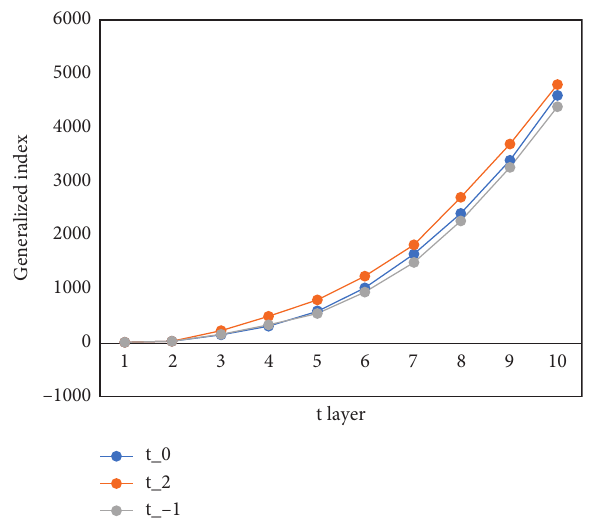
Figure 4: Numerical behavior of M c ( P